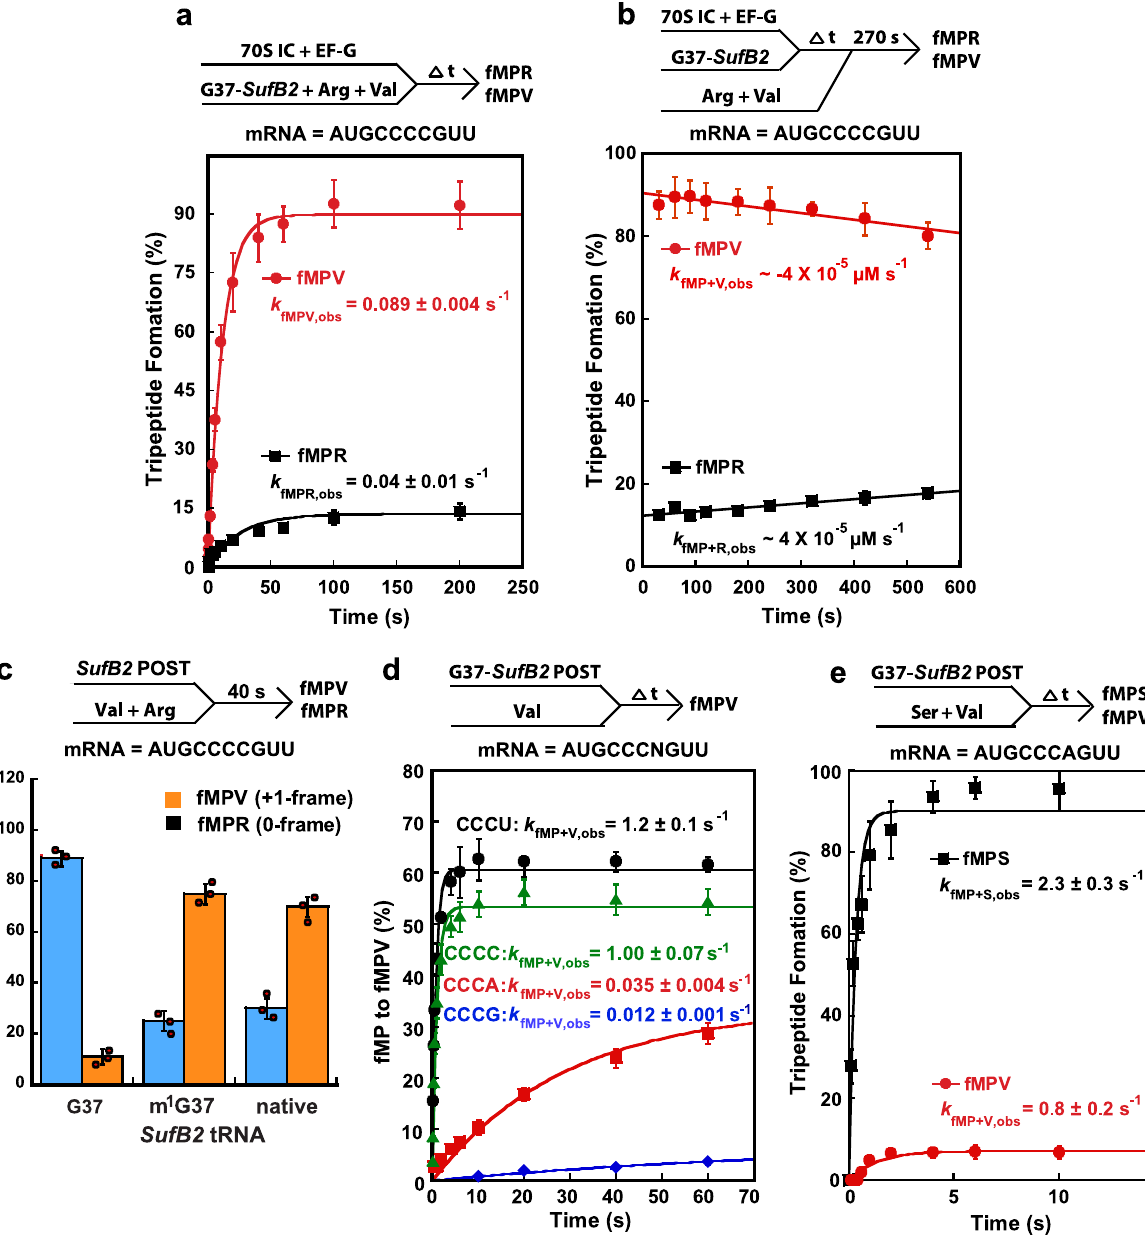
Fig. 5 SufB2 shifts to the + 1-frame during translocation. a Relative fMPV and fMPR formation as a function of time upon rapid delivery of EF-G and an equimolar mixture of G37-state SufB2 -, tRNA Val -, and tRNA Arg -TCs to 70S ICs carrying a CCC-C motif in the A site. b Relative fMPV and fMPR formation as a function of time when a de fi ned time interval is introduced between delivery of G37-state SufB2 -TC and EF-G and delivery of an equimolar mixture of tRNA Arg - and tRNA Val -TCs. c Relative fMPV and fMPR formation after reacting fMP-POST complexes with a mixture of tRNA Val - and tRNA Arg -TCs based on the time courses in Supplementary Fig. 2d – f. d fMPV formation as a function of time upon rapid delivery of tRNA Val -TC to an fMP-POST complex carrying a CCC-N motif in the A site. e Relative fMPV and fMPS formation as a function of time upon rapid delivery of an equimolar mixture of tRNA Val - and tRNA Ser -TCs to an fMP-POST complex carrying a CCC-A motif in the A site. In a – e the bars are SD of 3 ( n = 3) independent experiments and the data are presented as mean values ± SD. Arg: arginyl-tRNA Arg ; Val: valyl-tRNA Val